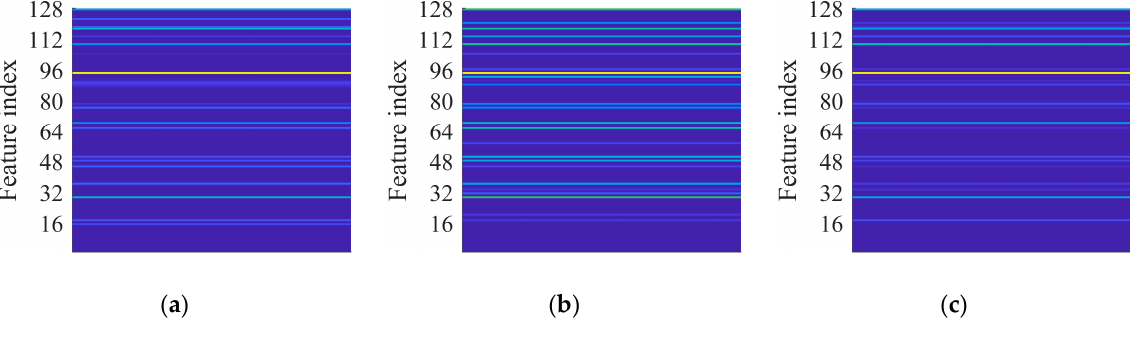
Figure 9. VGGish feature embedding at 997 rpm and 124.8 kN radial load: ( a ) normal health state; ( b ) IR damage; ( c ) OR damage.